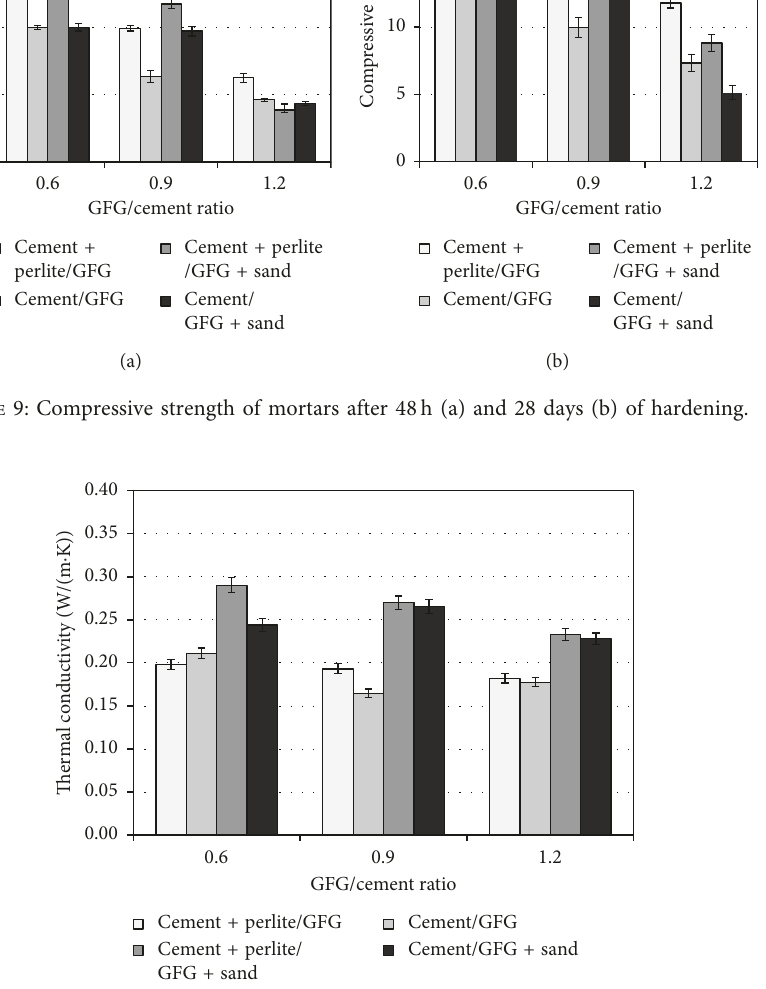
Figure 10: Thermal conductivity of mortars.